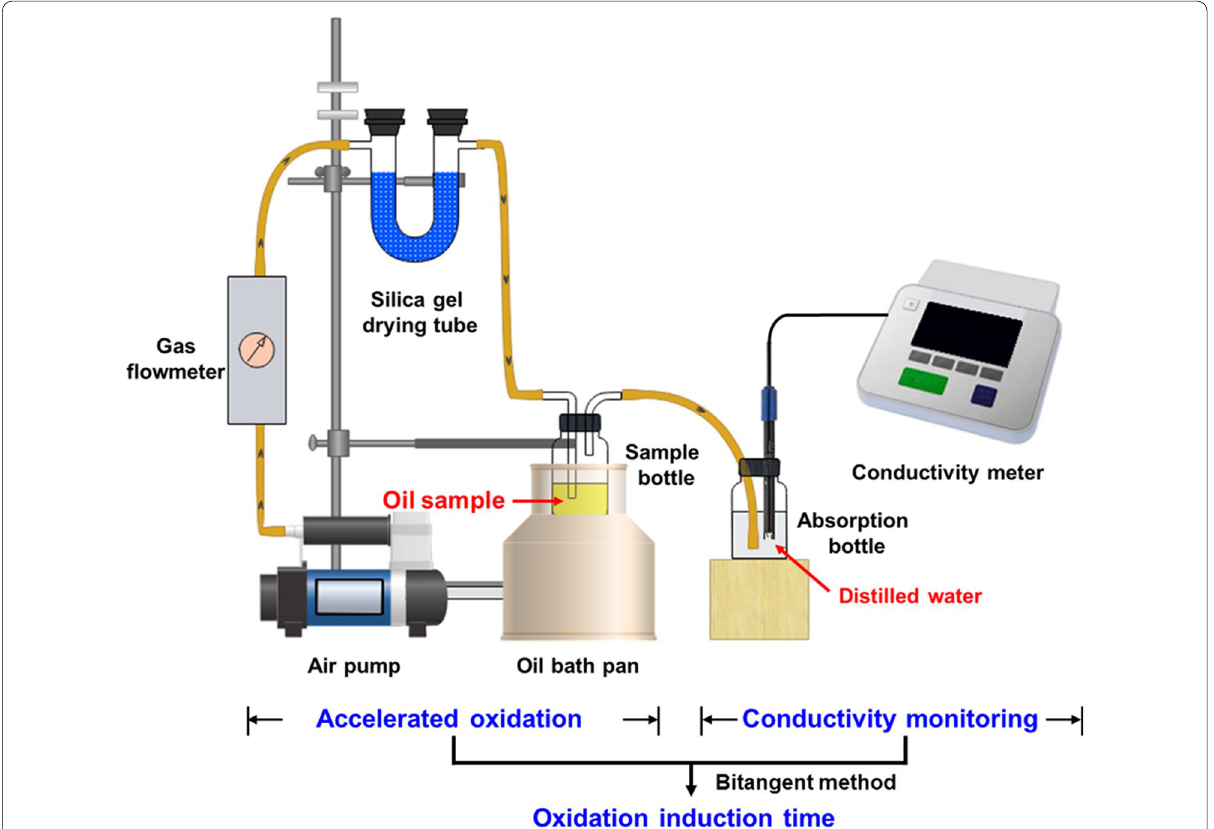
Fig. 1 Experimental apparatus for the acceleration of fatliquor